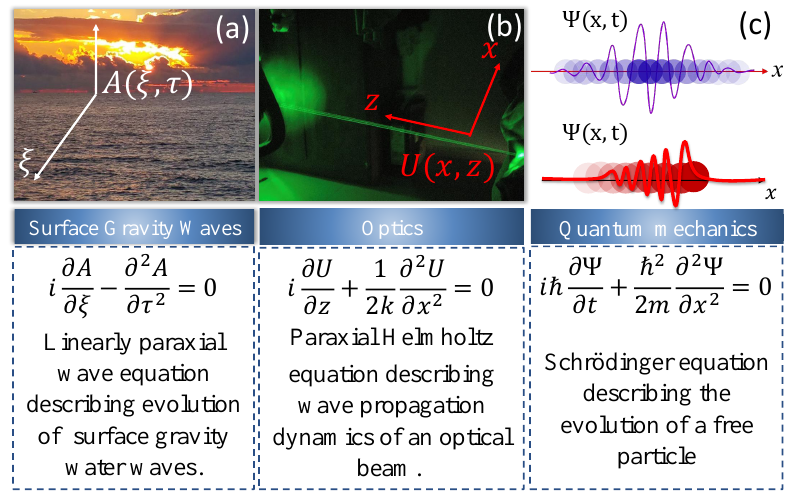
Figure 1. ( a ) Ocean surface gravity water waves propagating according to the linear paraxial wave equation. ( b ) A green laser beam (532 nm) propagating in free space, according to the paraxial Helmholtz equation. ( c ) An illustration of Gaussian (top) and Airy (bottom) wavefunctions which are solutions of the Schrödinger equation of a free